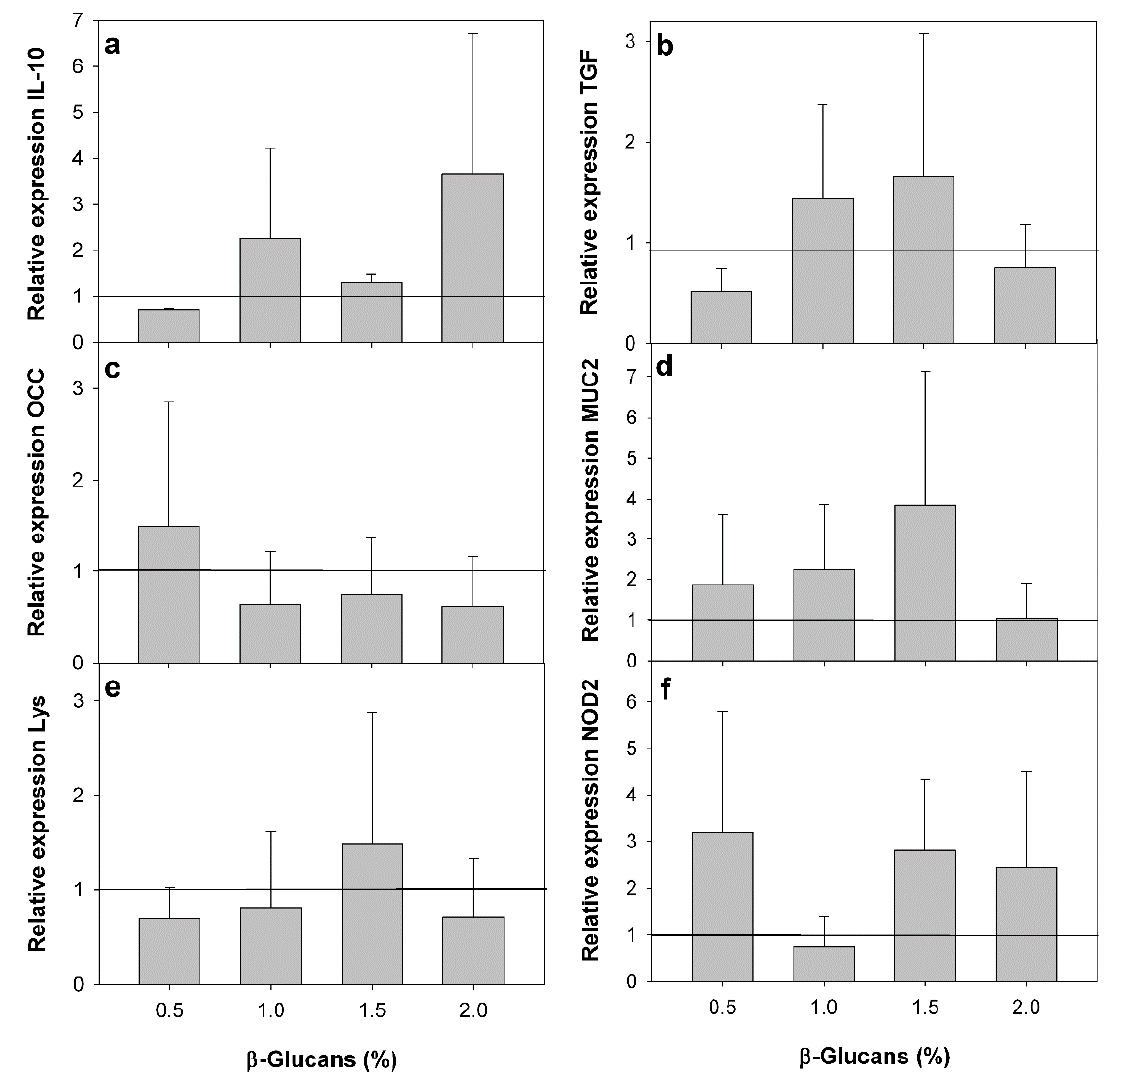
Figure 1. Box-plot of the relative expression different molecular markers from the intestinal tissue (median ± quartile 10%, n = 3) of A. tropicus juveniles normalized to the average of Elongation factor 1 ( EF1 ) and β -actin expression. ( a ) Interlukin-10 ( IL-10 ); ( b ) transforming growth factor ( TGF ); ( c ) Occludin ( OCC ); ( d ) Mucin2 ( MUC2 ); ( e ) Lysozyme ( Lys ); ( f ) nucleotide-binding and oligomerization domain 2 ( NOD2 ) (K-W, p > 0.05).